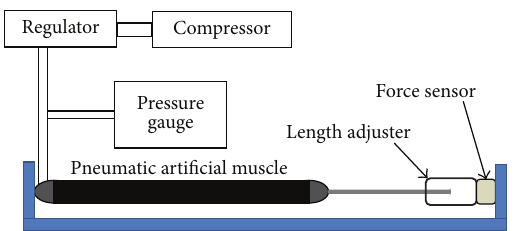
Figure 4: Measurement method for determining the force charac- teristics of the pneumatic actuator.